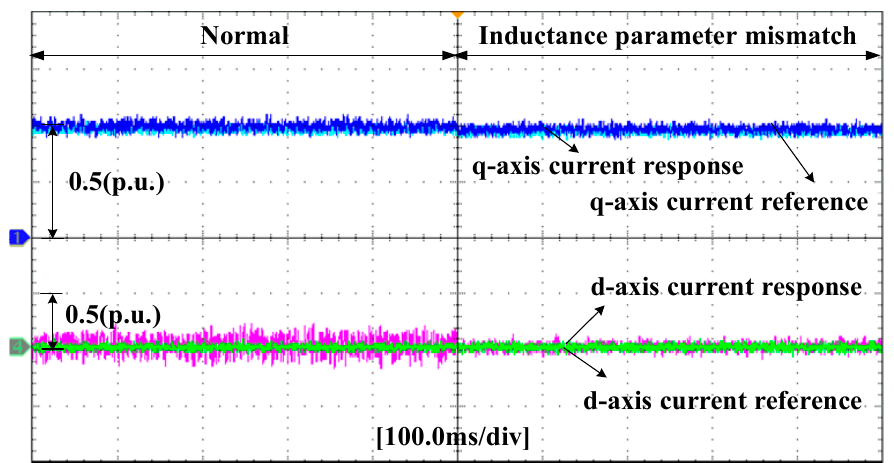
Figure 12. Experimental results of the RNPCC method under inductance parameter perturbation.